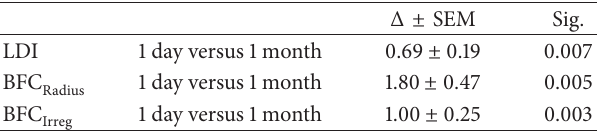
Table2:Statisticallysignificantchangesinparametersofmonocular LD overtime (mean difference ±